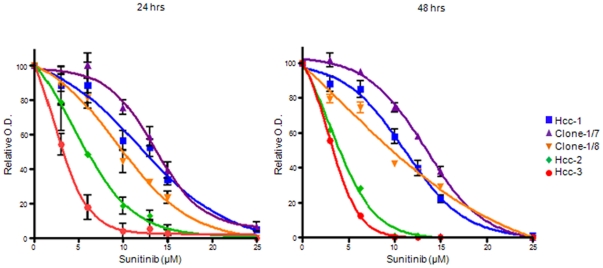
Drug resistance of the cell populations and clones.The MTT evaluation showed that the cell populations and clones had different chemoresistance to sunitinib after 24 (left) and 48 (right) hours of treatment. Mean ± standard deviation of three independent experiments.